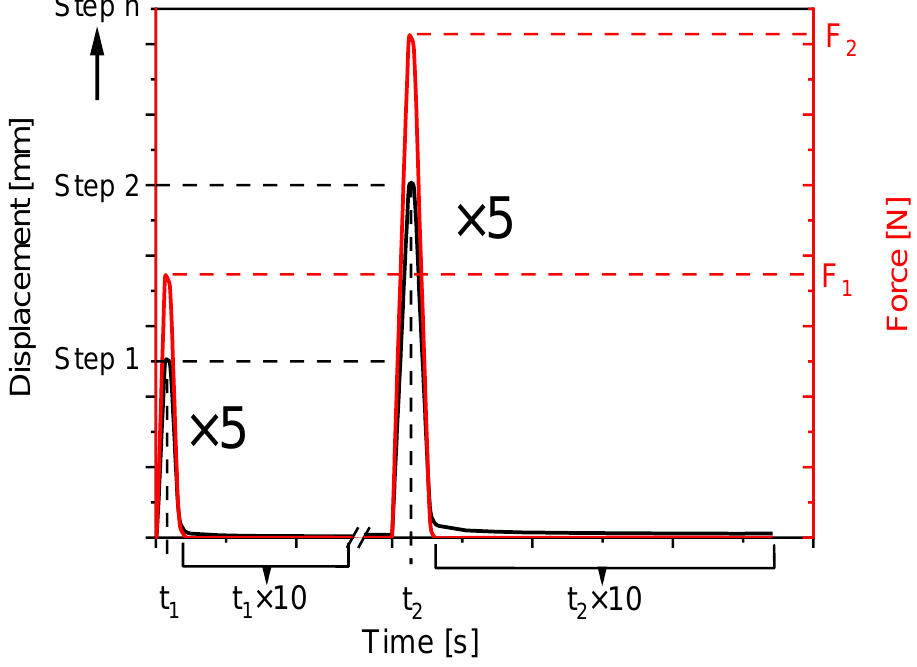
Figure 3. Test sequence of the increasing-load test to determine a strain limit for polyurethanes.